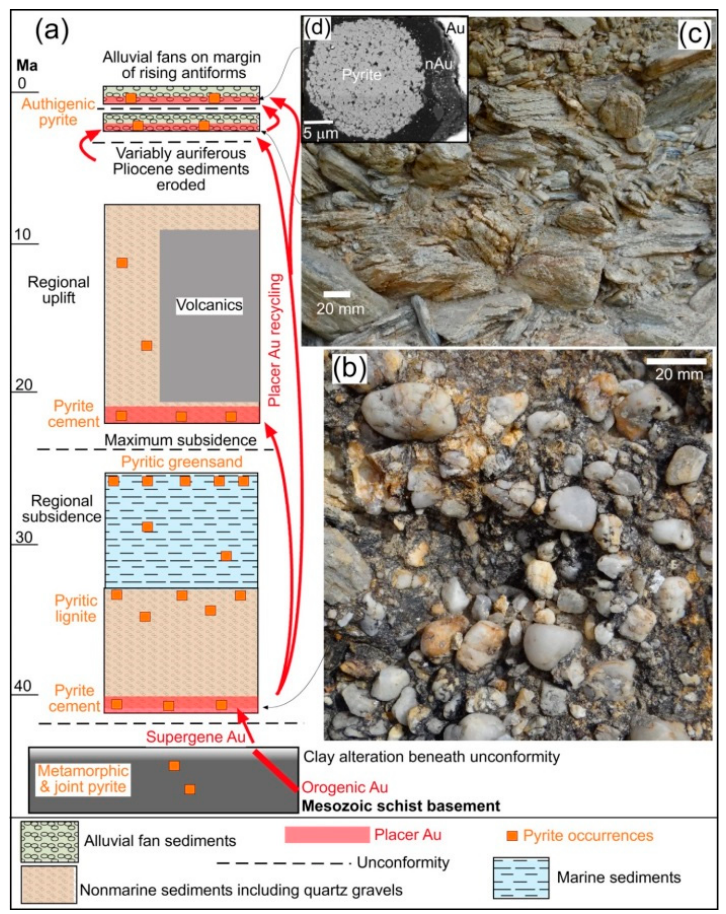
Figure 3. Stratigraphic setting for placer gold deposits in the eastern portion of the Otago rain shadow (Figure 1b). ( a ) Summary stratigraphic column, showing the principal rock types in the remnants of the sedimentary veneer, widespread distribution of authigenic pyrite, and typical placer gold recycling pathways; ( b ) Typical quartz pebble conglomerate, which is Eocene in this case, but recycled to Miocene farther inland; ( c ) Typical Pleistocene lithic conglomerate dominated by schist debris and cemented by clays and Fe oxyhydroxide, in outcrop above the water table; ( d ) scanning electron microscopy (SEM) image of a polished section of framboidal authigenic pyrite (left) coexisting with clay impregnated with nanoparticulate gold (nAu) and detrital gold (right).